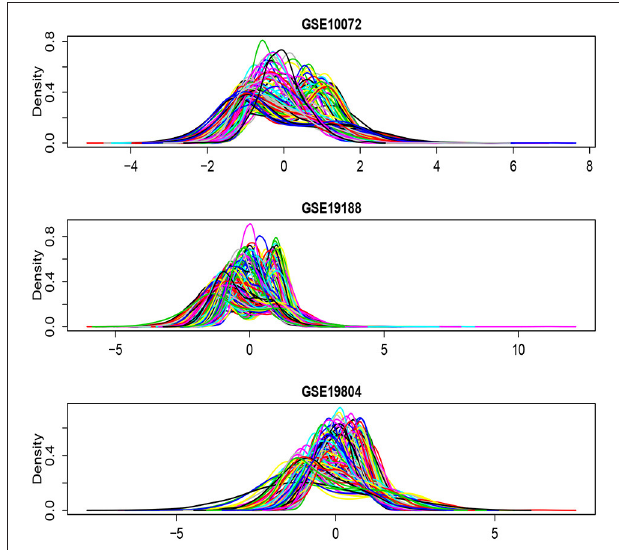
FIGURE 6 | Density plots for each of the selected 1,000 genes in the GSE10072, GSE19198, and GSE19804,